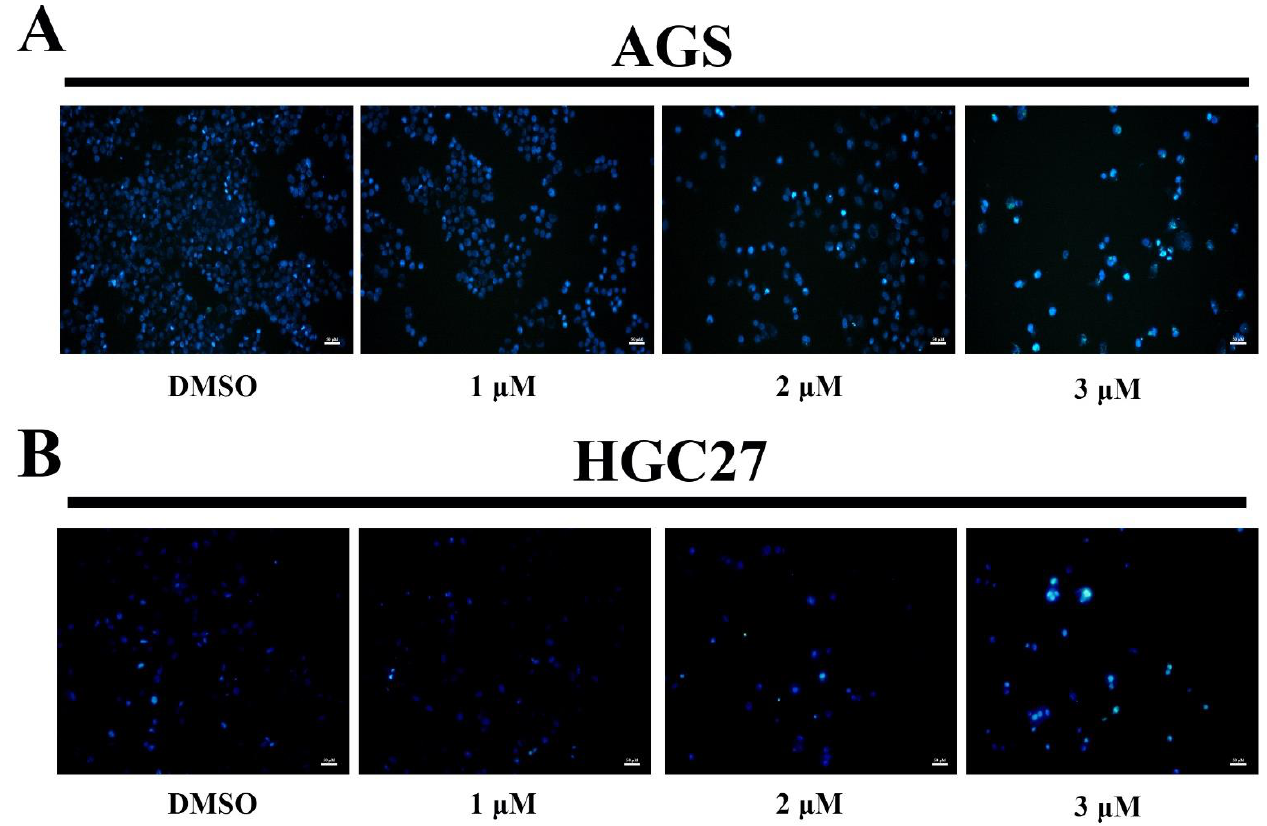
Figure 3. BLG26-induced apoptosis in AGS, HGC27 cells. ( A , B ) AGS cells were treated with BLG26 for 48 h and stained with Hoechst 33258. DMSO was used as negative control. Scale bar 50 μ M.